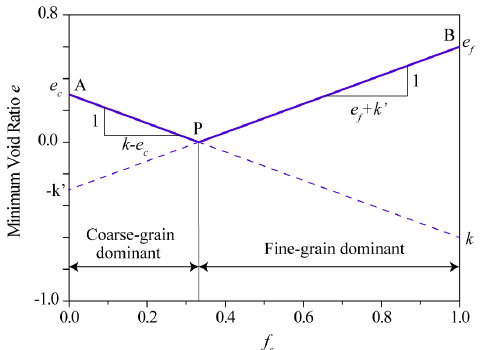
Figure 15. Changes of minimum void ratio of gap-graded SRM with f c .